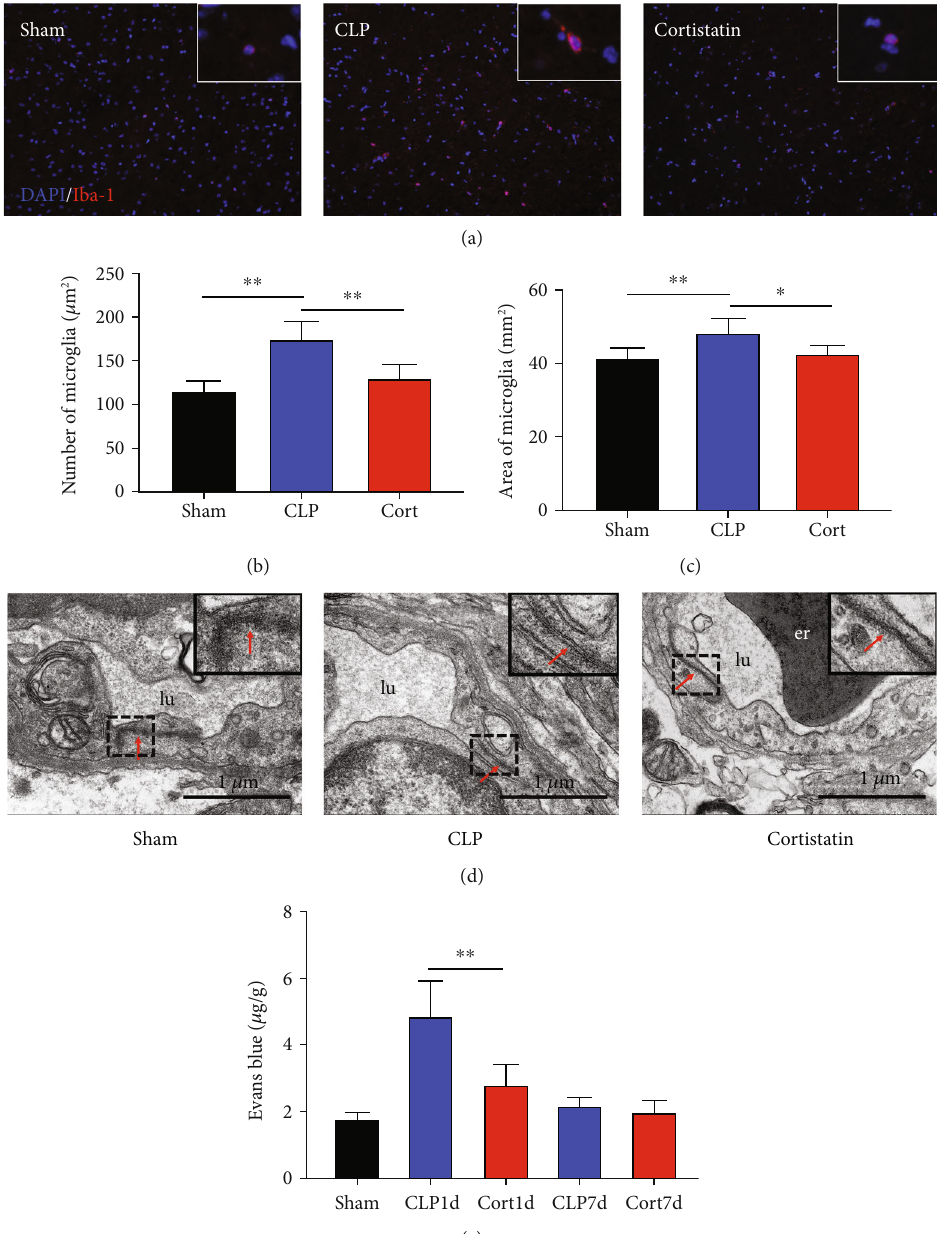
Figure 4: Cortistatin treatment alleviated microglial activation and BBB disruption. (a) Representative Iba1 and DAPI immuno fl uorescence staining in the prefrontal cortex. Representative magni fi ed Iba1 immunopositive cells were shown in the upper right corner of each group. (b) and (c) Statistical analysis of Iba1 immunopostitive cells counts in the prefrontal cortex. (d) Representative transmission electron micrographs of compact junctions between endothelial cells (red arrows). Representative tight junctions were shown in the upper right corner of each group. (e) Evans blue staining results to investigate the BBB permeability. ∗ P < 0.05, ∗∗ P < 0.01. Abbreviations: CLP, cecal ligation and puncture; Cort, cortistatin; er: erythrocyte; lu: